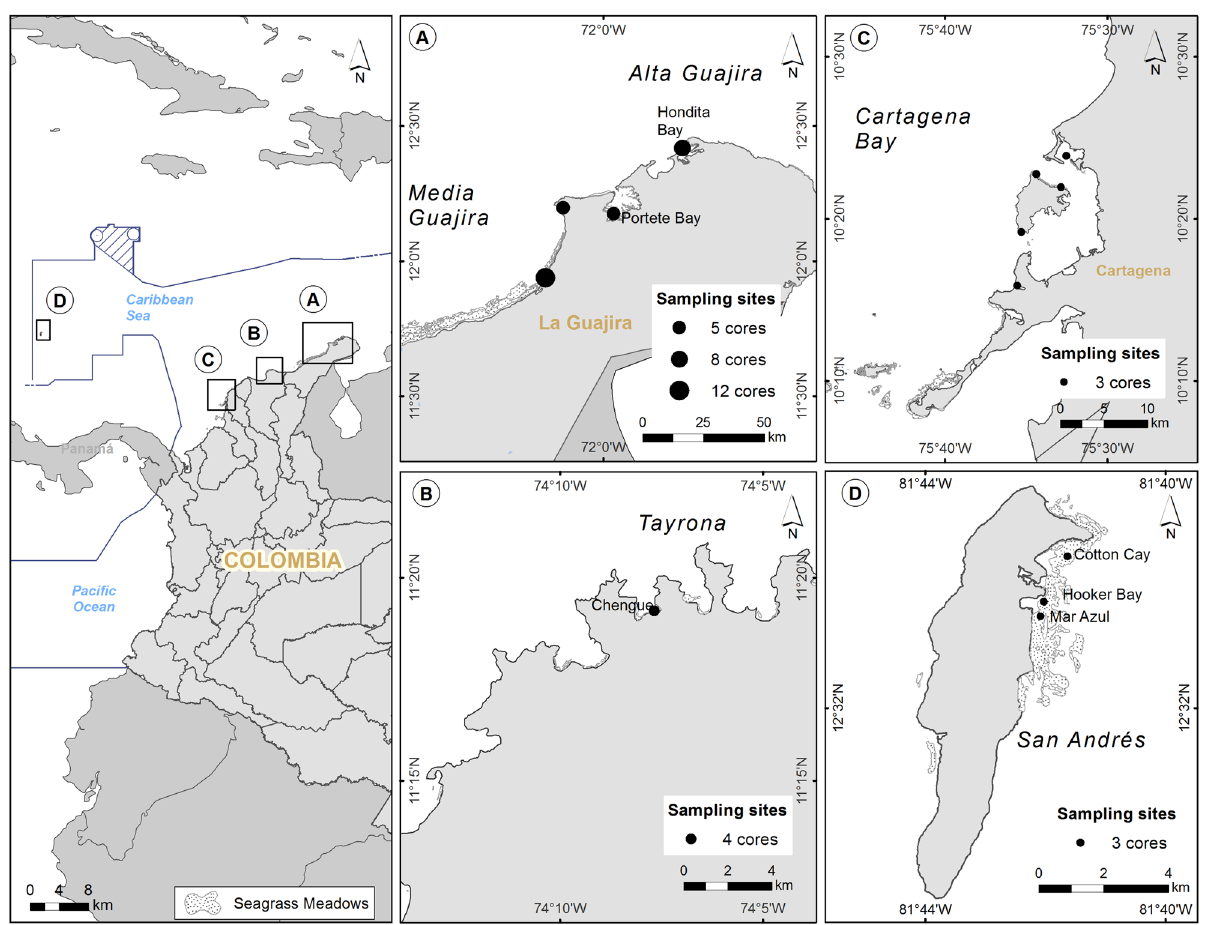
Figure 1. Seagrass meadow distribution and location of the sampling sites in the Colombian Caribbean. Left panel shows the location of the five regions studied (Alta Guajira, Media Guajira, Cartagena Bay, Tayrona and San Andrés). ( A – D ) show the sampling sites within each region. The size of the circles indicates the number of cores studied at each sampling site. The maps were created in ArcGis Online (https:// www. esri. com/ en- us/ arcgis/ produ cts/ arcgis- online/ overv